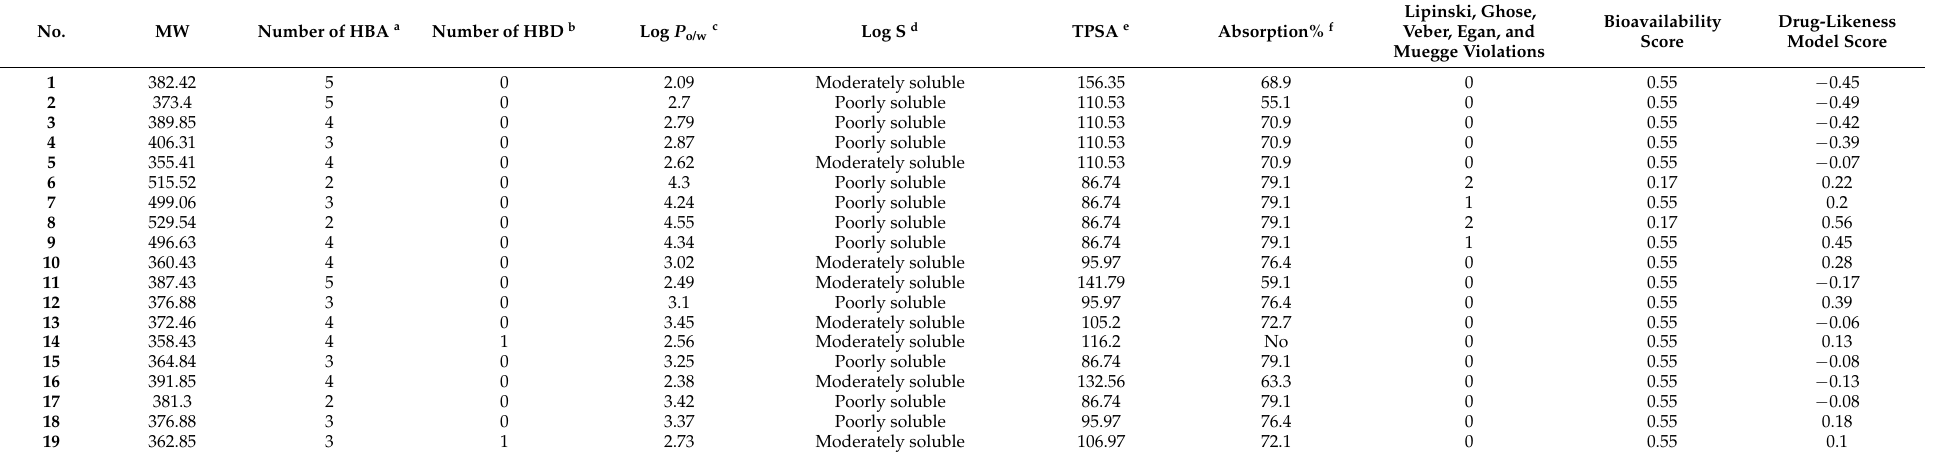
Table 7. Drug likeness predictions and physicochemical-pharmacokinetic/ADME properties of tested